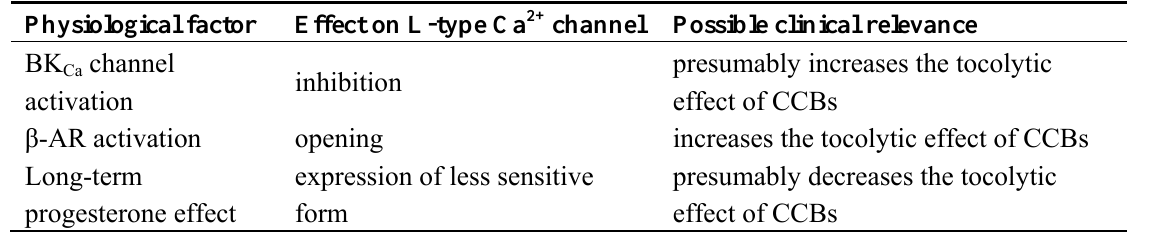
Table 1. Influence of some physiological factors on L-type Ca 2+ channels in the pregnant myometrium. Physiological